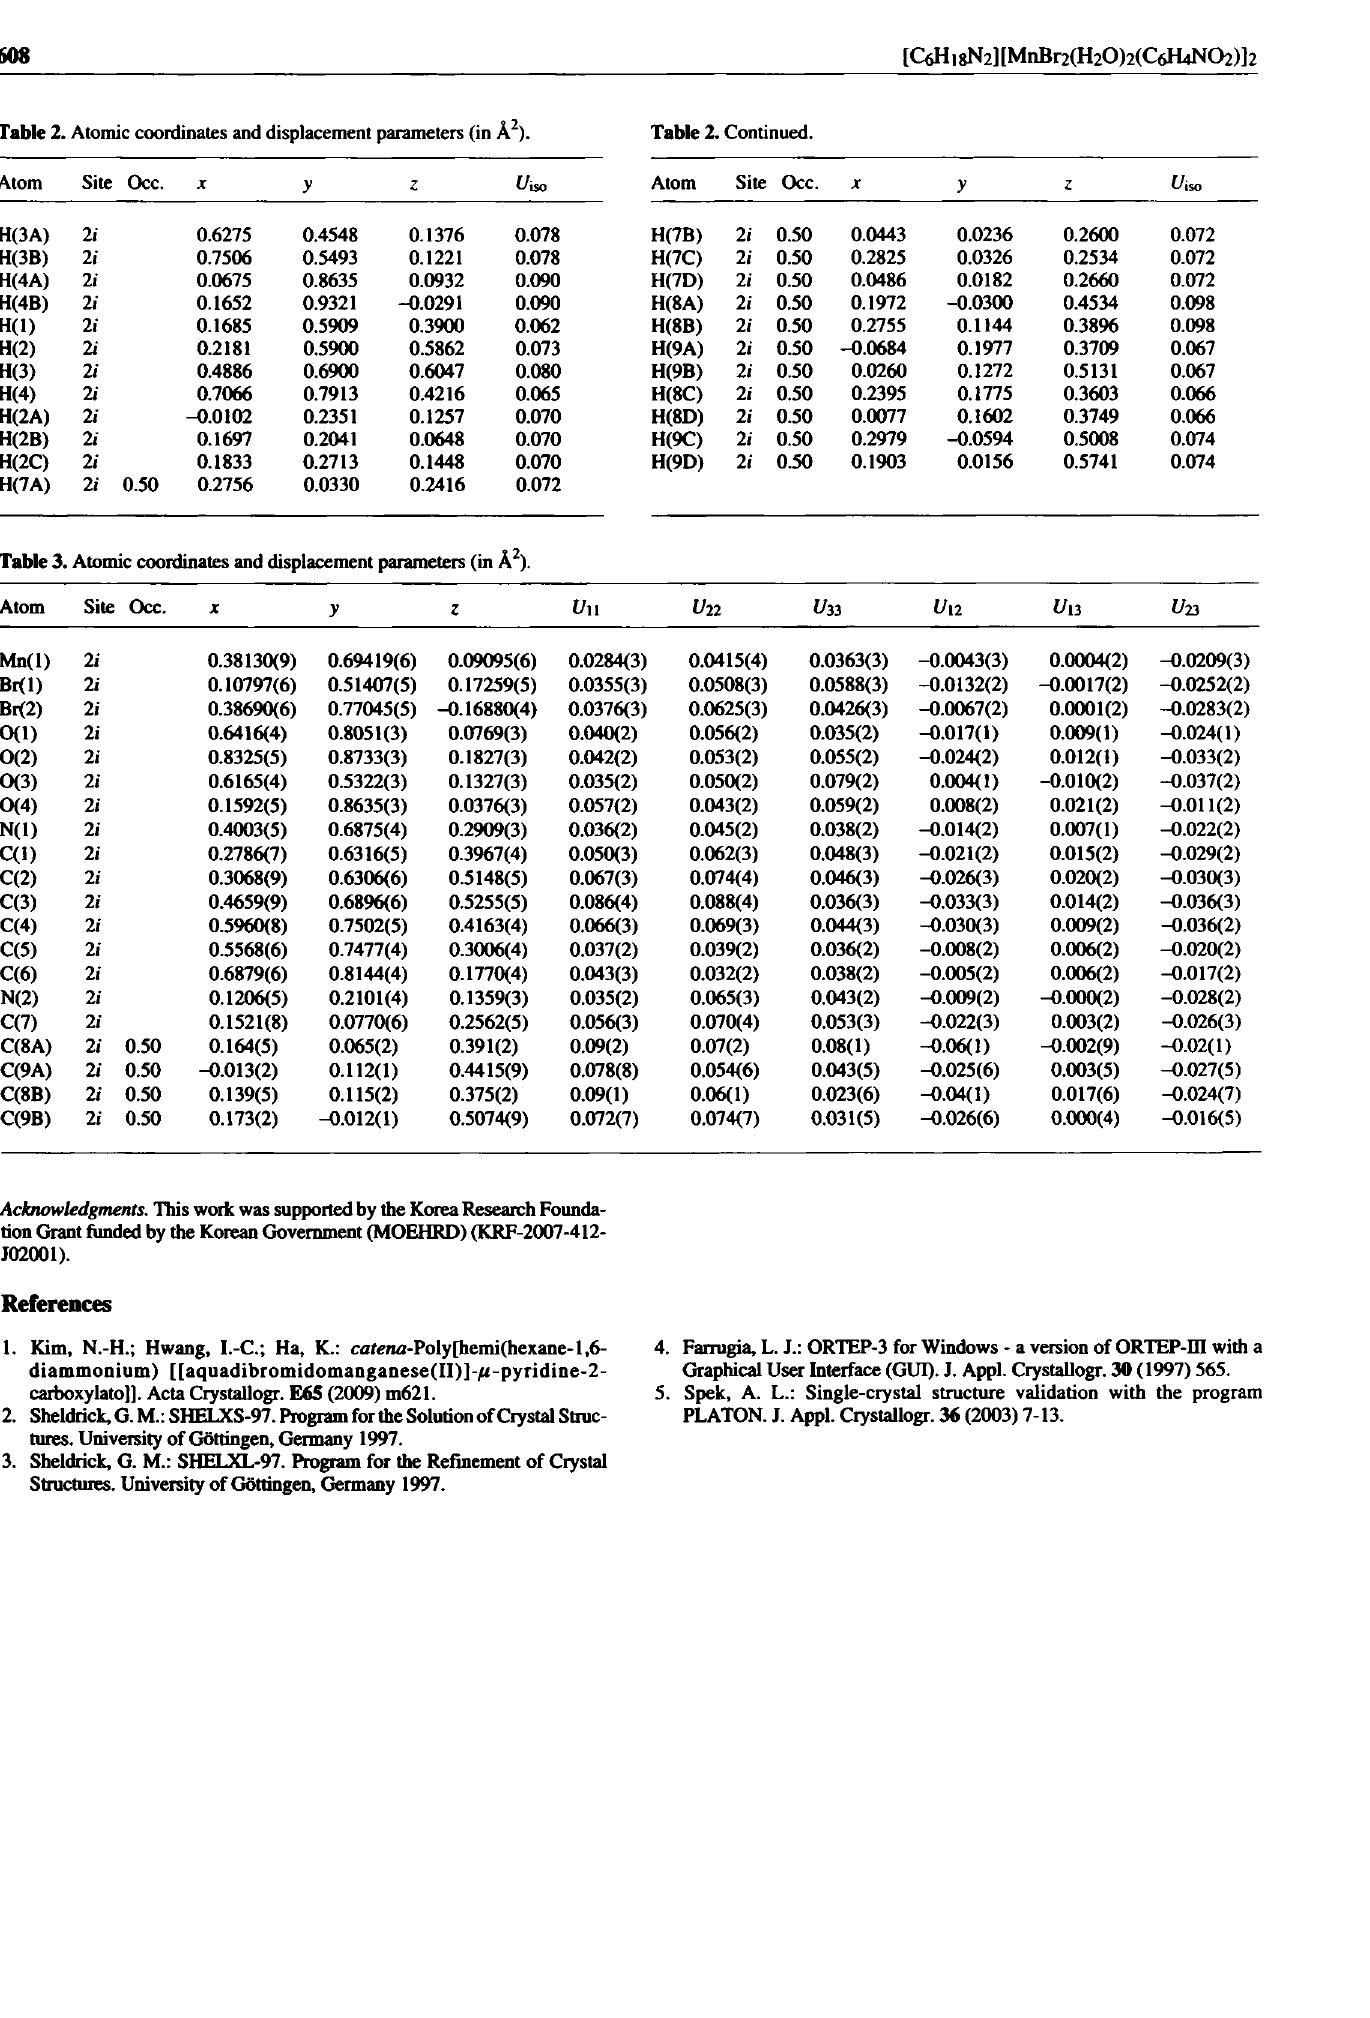
Table 2. Atomic coordinates and displacement parameters (in Â 2 ).